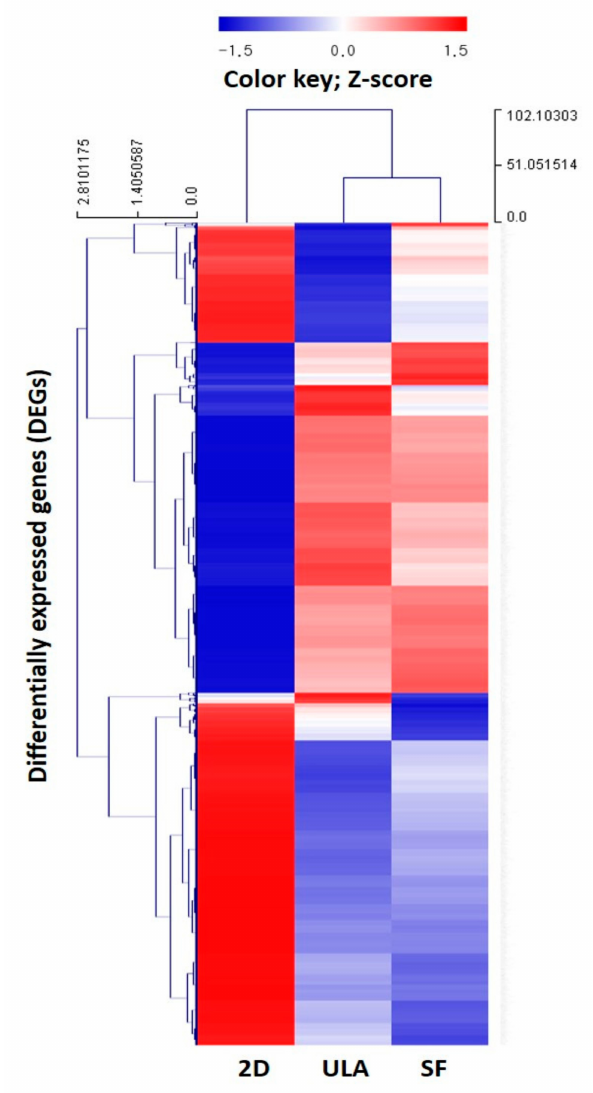
Figure 8. Heatmap illustrating Z-score normalized hierarchical clustering with dendrogram for three experimental groups. Transcripts with fold-change values larger than 2 with a p > 4, p -value < 0.05 were included in the analysis as di ff erentially expressed genes (DEGs). The red and blue color indicate up- and down-expression of Z-score, respectively. Color density indicating the levels of fold changes are